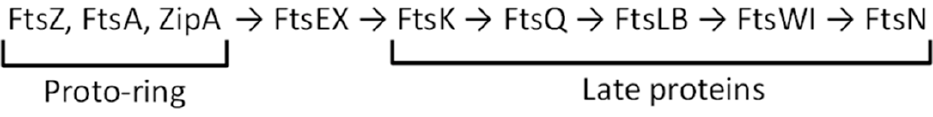
Figure 1. Hierarchical recruitment of divisome proteins.